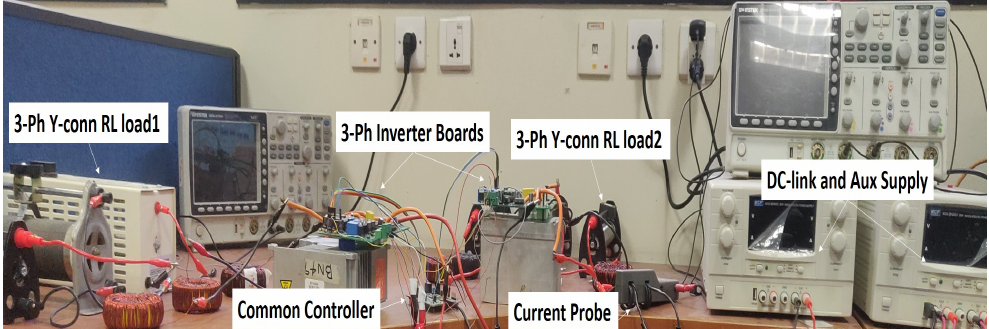
Figure 15. Hardware